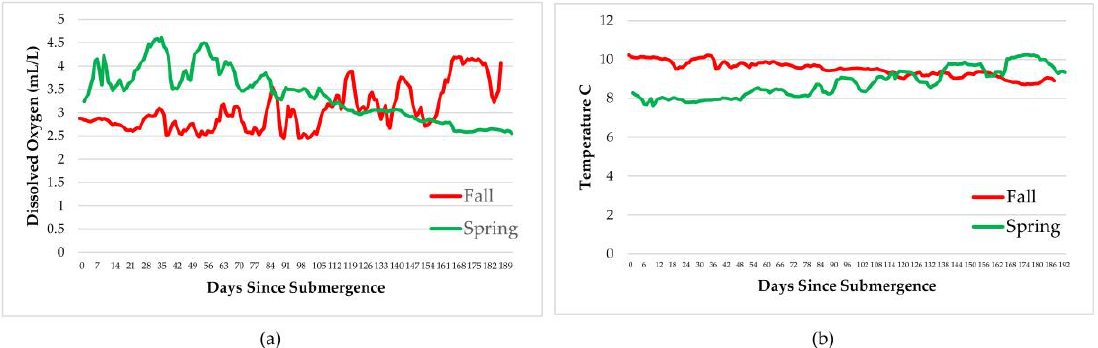
Figure 4. Daily average dissolved oxygen levels ( a ) and temperature ( b ) over the duration of the experiments at a depth of 170 m in the Strait of Georgia in spring and fall (Ocean Network Canada’s VENUS observatory).